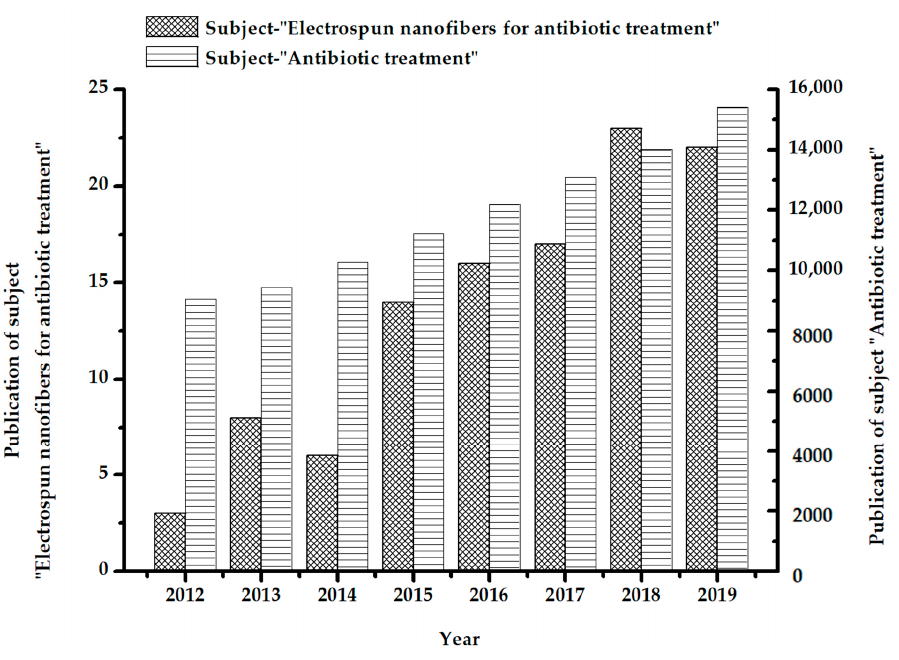
Figure 2. Statistics of literature retrieved on the “Web of Science” platform with the theme of “Electrospun nanofibers for antibiotic treatment” and “Antibiotic treatment”. Table 1. Classification and some physicochemical properties of common antibiotics.